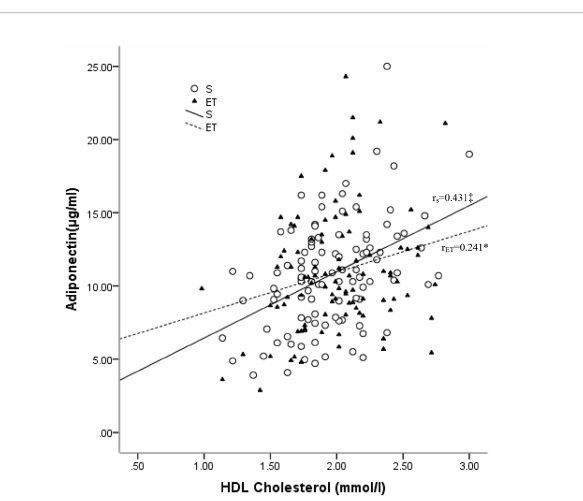
FIGURE 2 Relationships between plasma levels of adiponectin and L/Tr ratio in the sedentary (S) and endurance-trained (ET) groups. r S : correlation coef fi cient of the sedentary group; r ET: correlation coef fi cient of the endurance-trained group. *: P < 0.05; † : P < 0.01; ‡ : P < 0.001 .